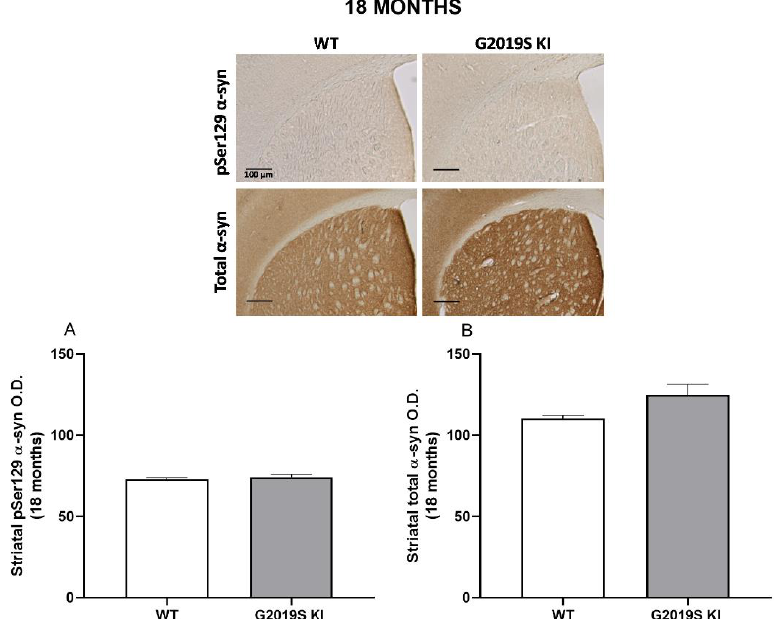
Figure 8. pSer129 and total α -synuclein levels are unchanged in the striatum of 18-month-old G2019S KI mice. Immunohistochemistry in striatal slices of 18-month-old G2019S KI mice in comparison with age-matched WT mice. Optical density (O.D.) of pSer129 α -syn ( A ) and total α -syn ( B ) immunostaining was quantified. Data are expressed as mean ± SEM of n = 8 mice per group. Representative images were provided in the upper panels (scale bar = 100 µm).